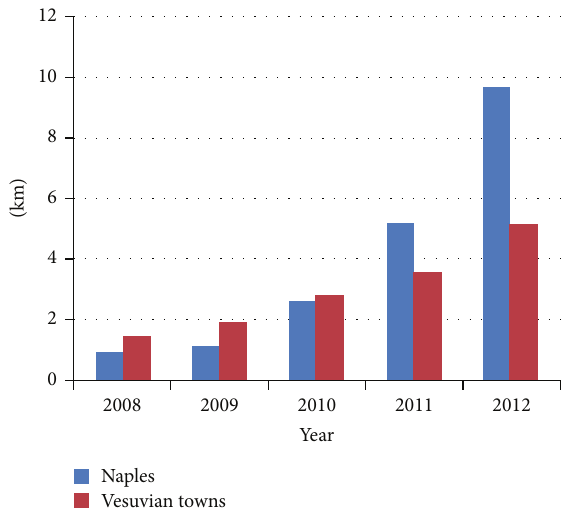
Figure 11: Carcinoma disease—histogram showing the variation of the radius of the two hotspots over